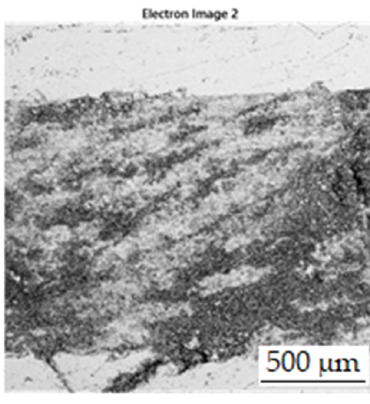
Figure 13. Wear track profile of alloy in the reduced state and the alloy sintered at 900 °C.